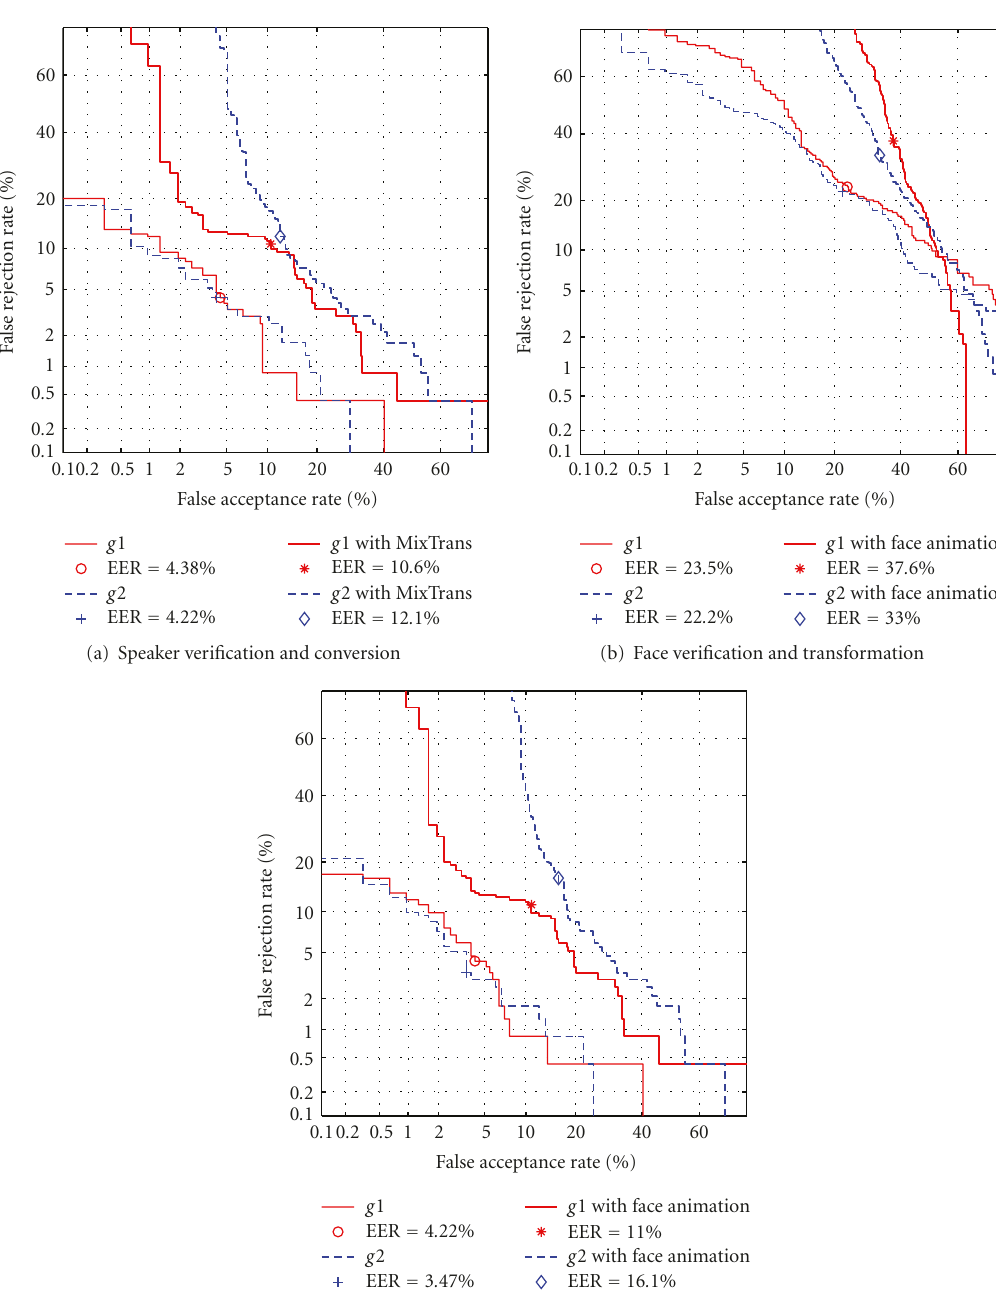
Figure 14: Audiovisual verification and imposture results on